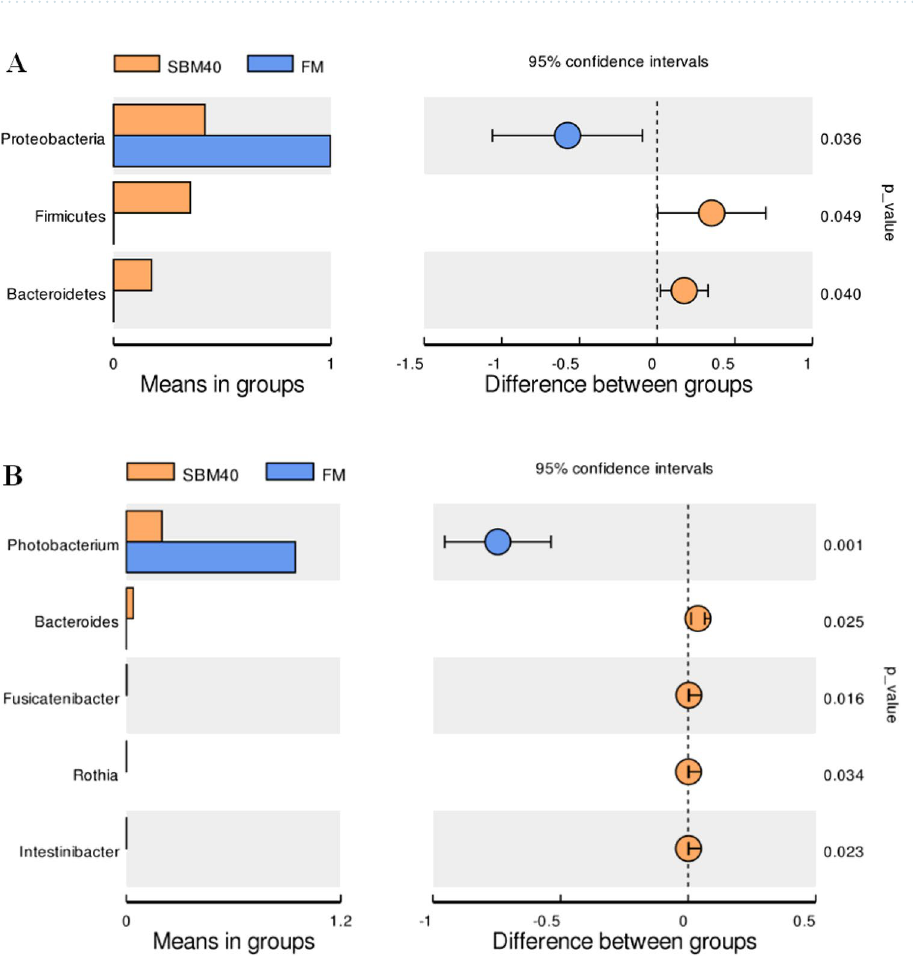
Figure 6. Differential analysis of intestinal microflora abundance of pearl gentian grouper fed by FM and SBM40 diets by T-test. A, phylum level; B, genus level (n =